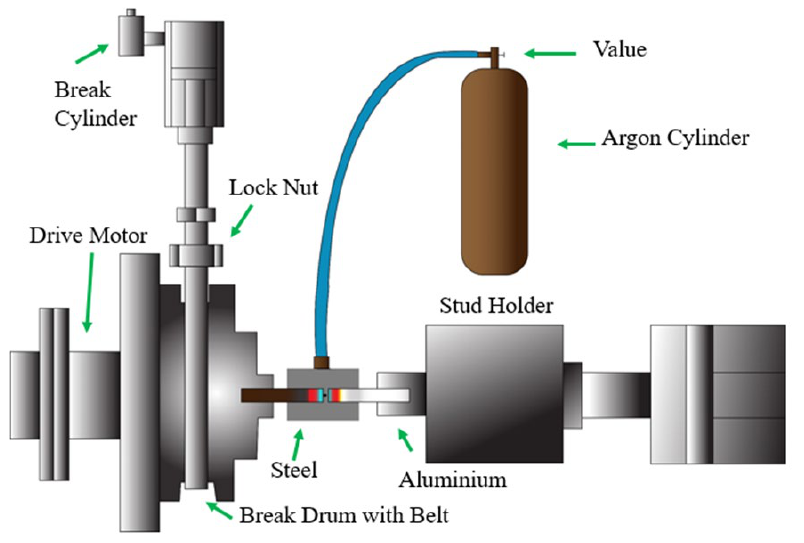
Figure 1. Schematic representation of argon shielding in friction stud welding.